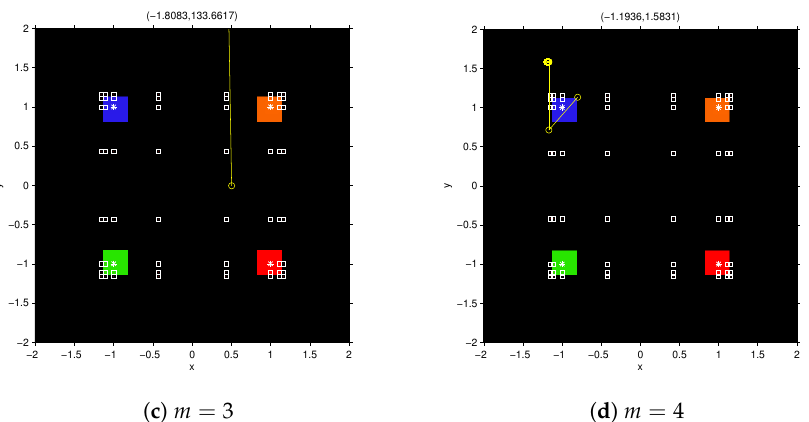
Figure 7. Dynamical plane for RMN m method, m = 1,2,3,4 on r ( x ) . Green, orange, red and blue areas are the basins of attraction of the roots of q ( x ) (marked as white stars); black area denotes divergence and white squares are free critical